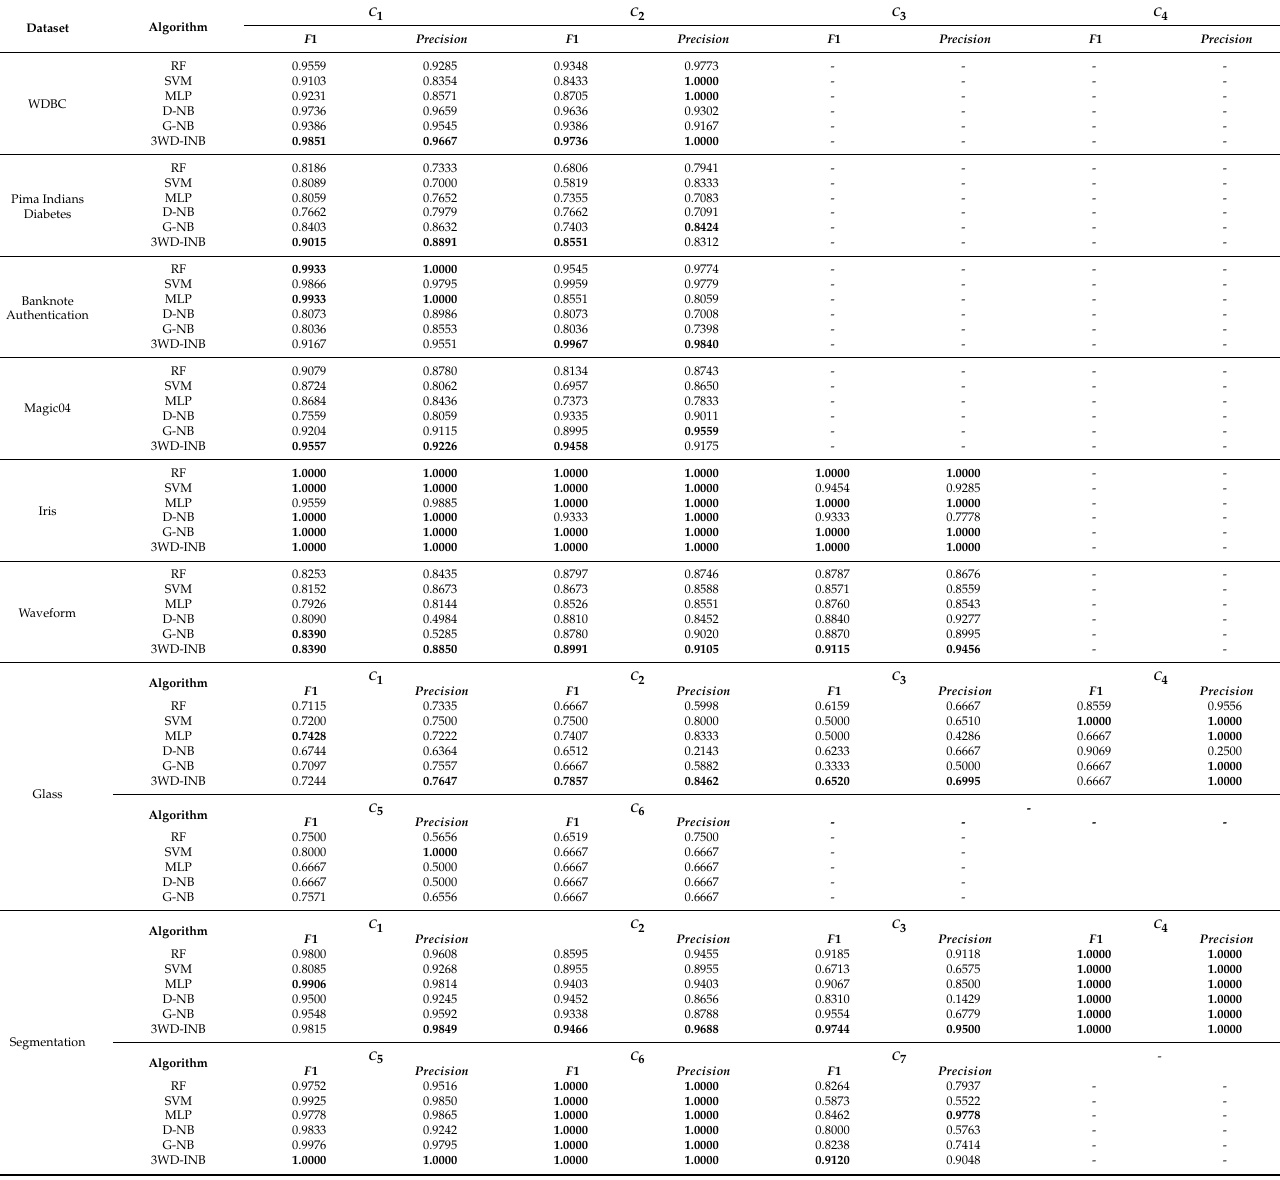
Table 9. 3WD-INB Experimental Result 2 (bold is the best